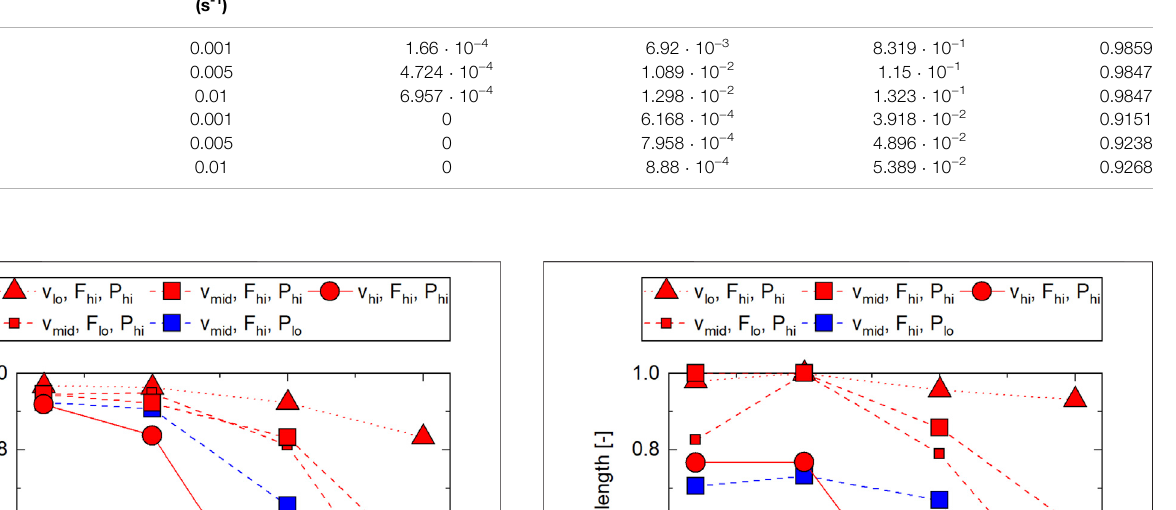
TABLE 6 | In-plane shear modulus — parameters of fi ts. Temperature ( ° C)